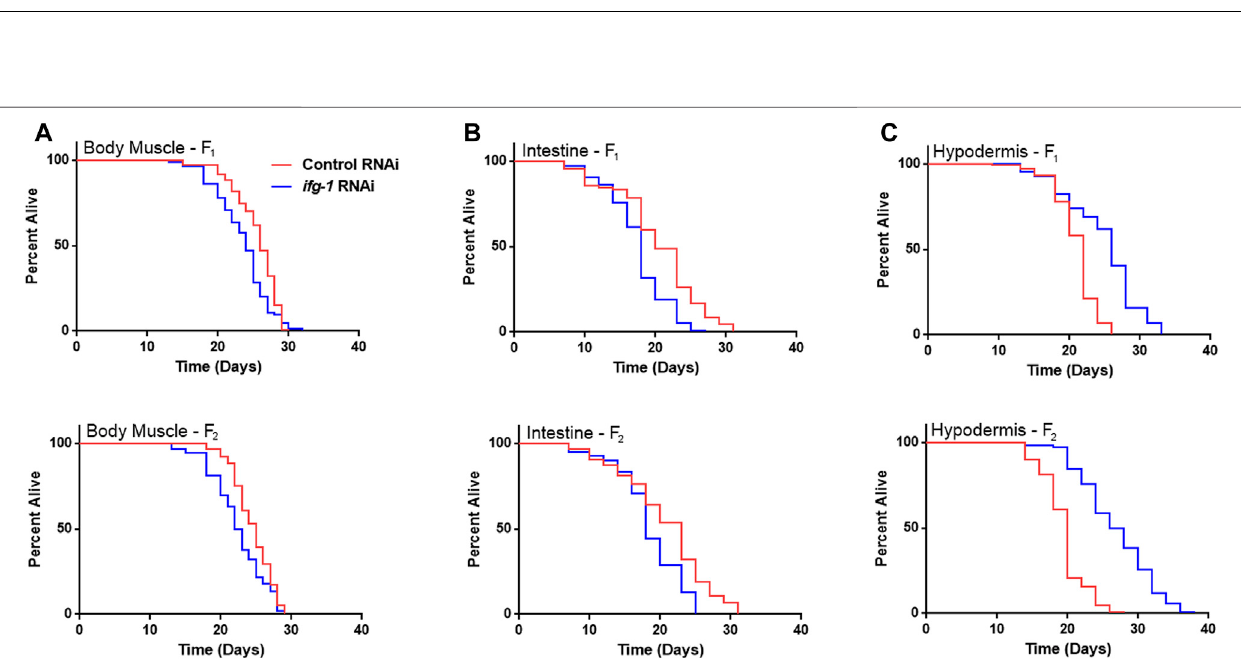
Frontiers in Aging |